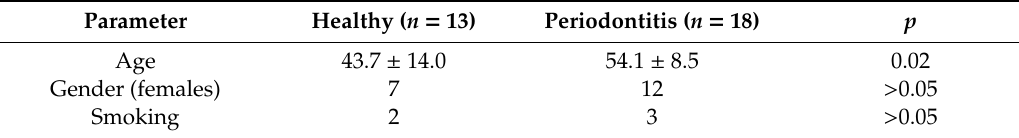
Table 1. Characteristics of study